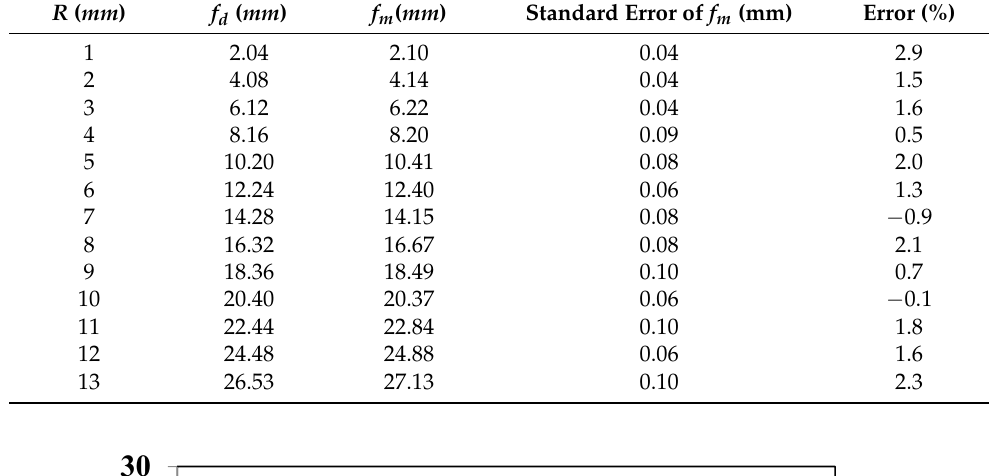
Table 1. Comparison of the measured and designed focal lengths, where R is radius of curvature, f d is the designed focal length, and f m is the measured focal length respectively.